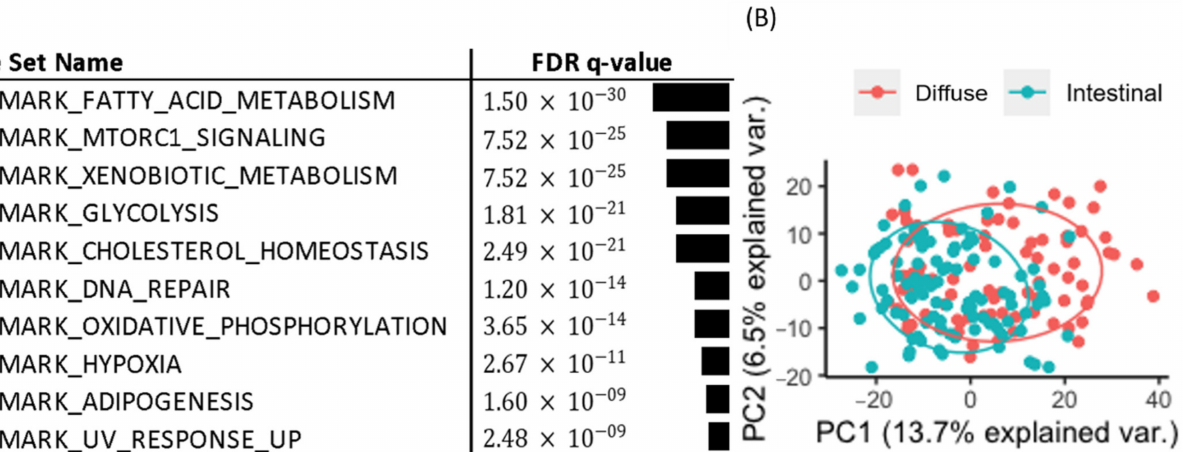
Figure 1. Overview of this study. Gene expression profiles of Lauren diffuse and intestinal GC subtypes were used to extract subsets of GEMs (i.e., all metabolic reactions in a cell) using iMAT and Metabolizer. The genes in GEM modules were validated in independent GC datasets. To identify functional contexts, gene set analysis for hallmark gene sets from MSigDB was applied to the gene expression profiles. GC: gastric cancer; TCGA: the Cancer Genome Atlas; STAD: stomach adenocarcinoma; GEM: genome-scale metabolic model; iMAT: integrative metabolic analysis tool; MSigDB: the Molecular Signatures Database; GDSC: the Genomics of Drug Sensitivity in Cancer; and DepMap: the Dependency Map.